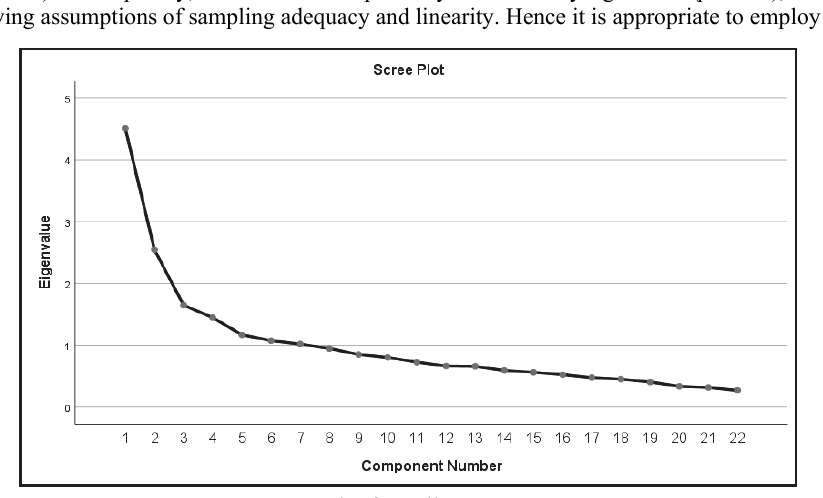
Fig. 1. Scree Plot for Failure